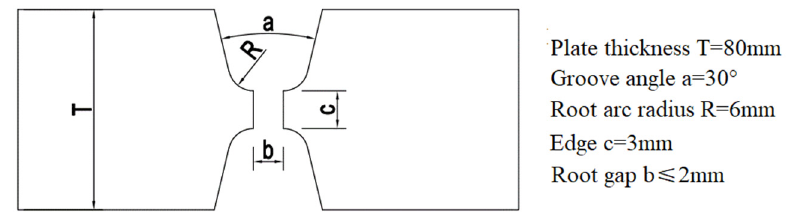
Figure 3. The joint details.